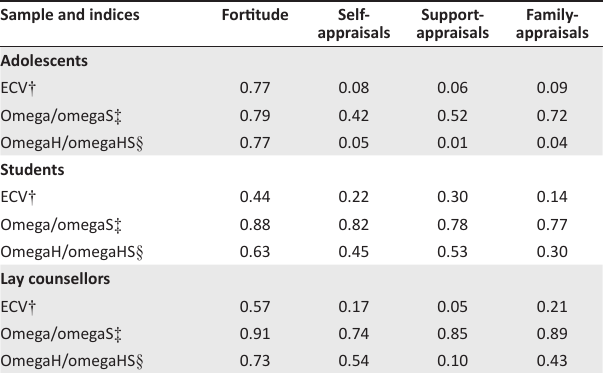
TABLE 3: Dimensionality indices for the Fortitude Questionnaire. Sample and